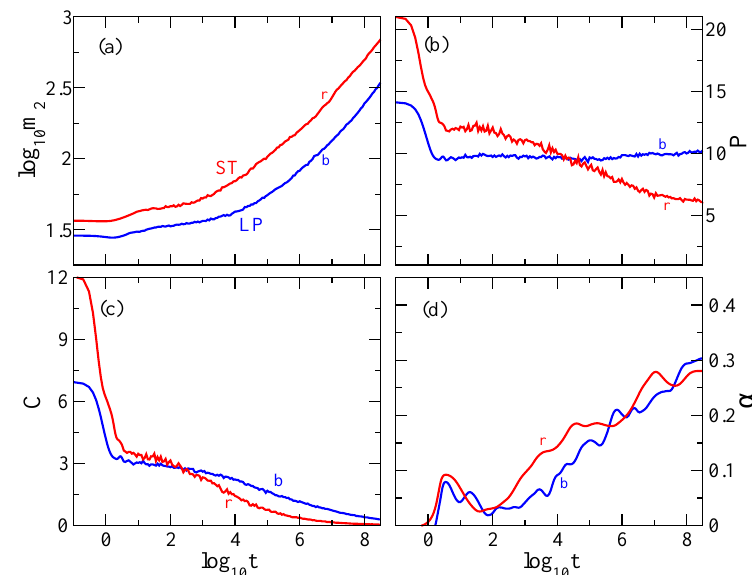
Figure 5: Density resolved wave packet spreading in the Lifshits phase (b)lue lines, ( t ) vs. log m t . (b) P vs. log t . and the self-trapping regime (r)ed lines. (a) log 2 10 10 10 t . (d) α vs. log t . Lifshits phase: h = − 0.277. Self-trapping regime: (c) C vs. log 10 10 h = 0.277. Other parameters: W = 4, a = 0.1, N = 2 10 , averaging over 200 disorder realizations for LP, 100 for